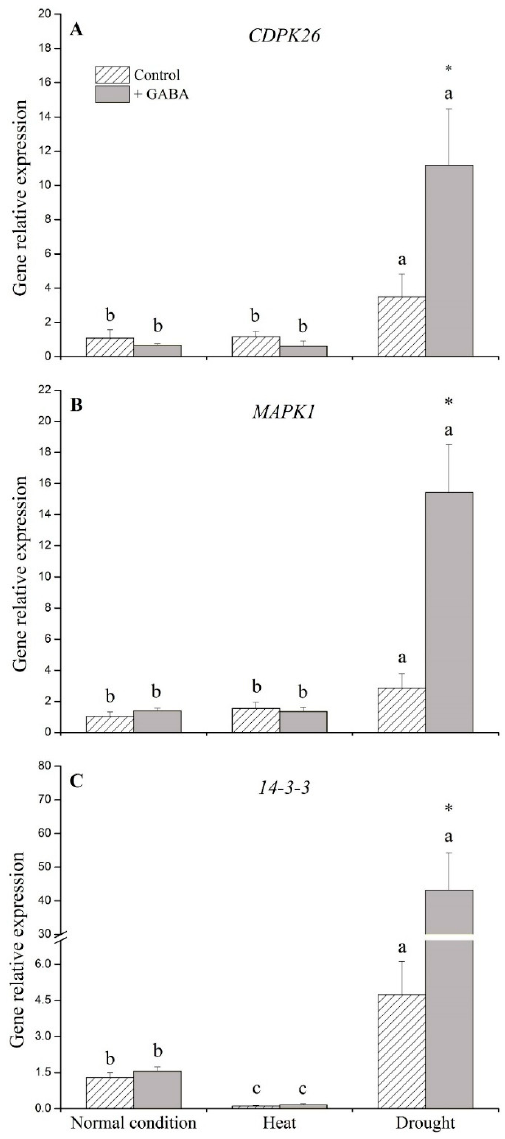
Figure 4. Effects of γ -aminobutyric acid (GABA) on genes’ expression of ( A ) CDPK26 , ( B ) MAPK1 , and ( C ) 14-3-3 under normal, heat, and drought conditions. Vertical bars indicate ±SE of mean ( n = 4). Different letters above columns indicate significant differences for one particular treatment (control or +GABA) under different conditions; asterisk “*” indicates significant difference between control and +GABA treatment under a given condition.